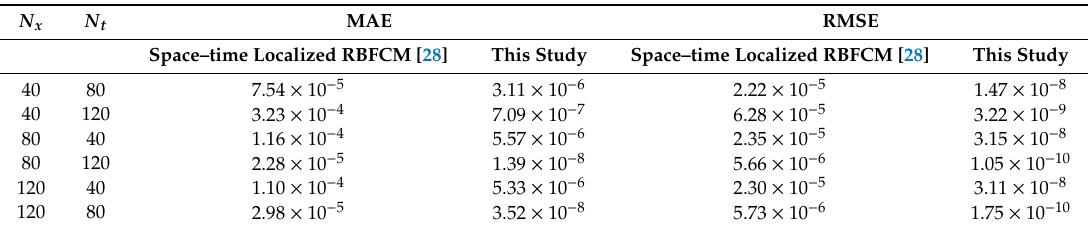
Figure 9. Comparison of the computed temperature. Table 2. The maximum absolute error (MAE) and root mean square error (RMSE) of the proposed approach and the space–time localized radial basis function collocation method